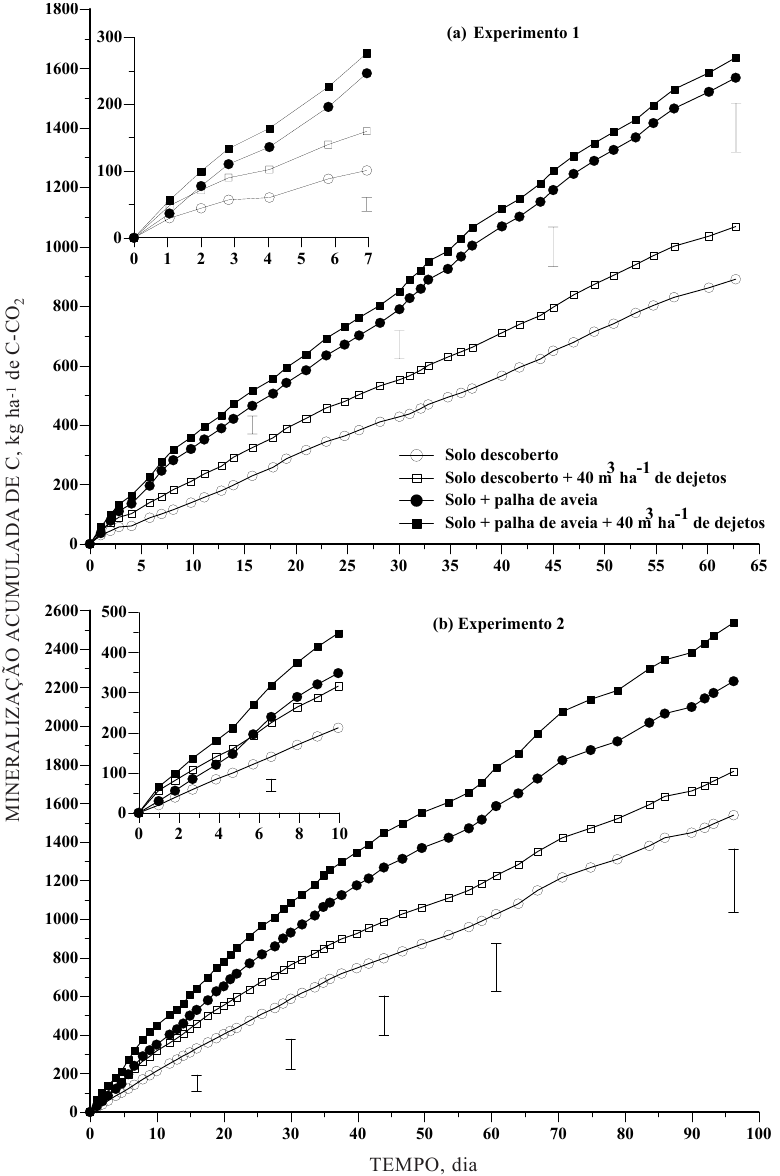
Figura 3. Mineralização acumulada de C (kg ha -1 de C-CO ), com e sem a aplicação de 40 m 3 ha -1 de dejetos 2 de suínos em solo descoberto e sobre a palha de aveia nos experimentos 1 (a) e 2 (b). A figura menor, no detalhe, refere-se a uma ampliação do intervalo de 0 a 7 dias no experimento 1 e de 0 a 10 dias no experimento 2. As barras verticais indicam a diferença mínima significativa (Tukey a 5 %) em datas de avaliação, escolhidas